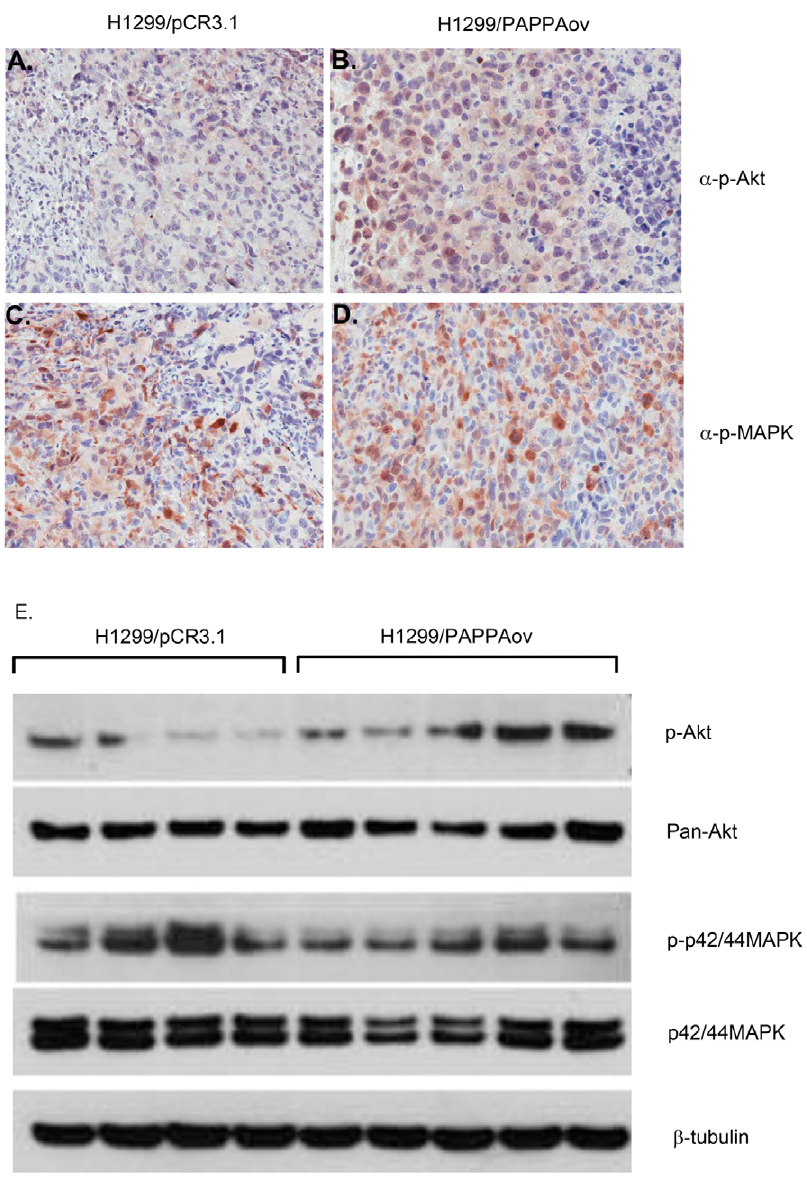
Figure 7. Evaluation of IGF signal transduction in xenograft tumor over-expressing PAPPA. Left panel: Immunostaining for phosphor-Akt (A and B) and phosphor-p42/44 MAPK (C and D) on tumor tissue from H1299/pCR3.1 cells (A and C) and from H1299/PAPPAov cells (B and D). Right panel: western blot quantification of proteins related to IGF signal transduction pathway: P-Akt and P-p42/44 MAPK on protein extracts from tumor tissues. P-: